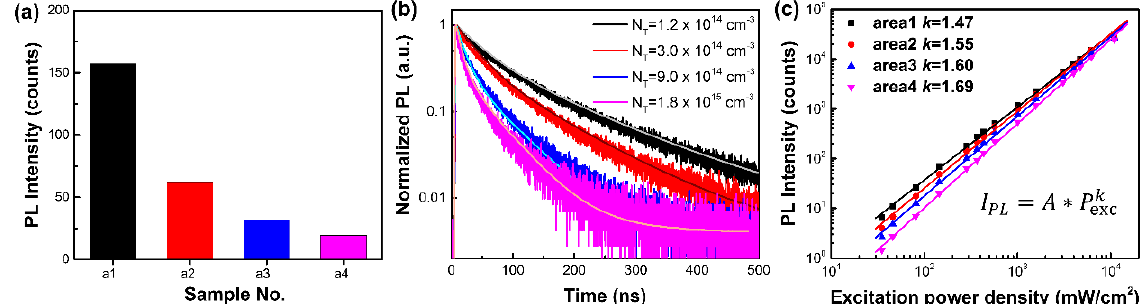
Figure 3. ( a ) PL intensity of four areas after BQ vapor treatment of different irradiation durations; ( b ) time-resolved PL decay kinetics and the fitted results of the four areas. Concentrations of deep traps, N T , evaluated by the PL decay kinetics, are indicated by the legend. The excitation fluence is 2.5 μJ/cm 2 ( n 0 ~3.3 × 10 16 cm −3 ) at 532 nm, 1 MHz; ( c ) PL intensity ( I PL ) as a function of excitation intensity ( P exc ). The dots are experimental results, and the solid lines are fitted results using the power law relationship I PL = A × P k exc